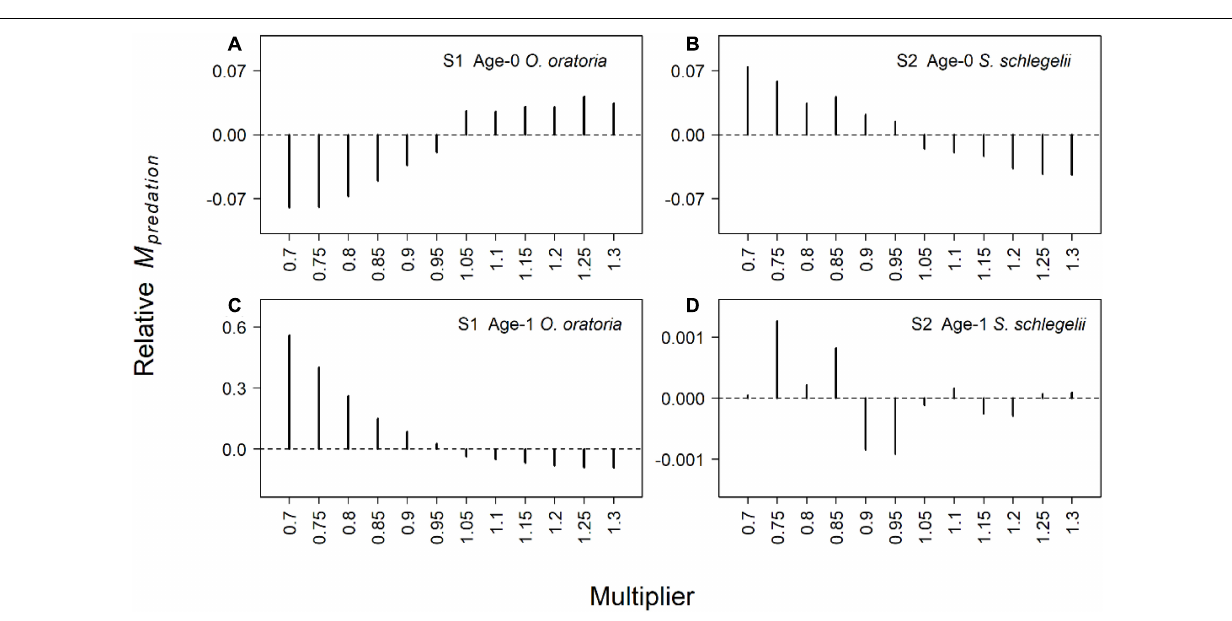
FIGURE 4 | Relative changes of predation mortality rate for two age groups of target species under different fishing scenarios. The relative changes were the difference between scenarios S1–2 and reference state. Scenarios S1 and S2 considered O. oratoria and S. schlegelii as target species, respectively. The fishing mortality multipliers of each non-target species were set from 0.7 (Fx0.7) to 1.3 (Fx1.3) with a step equal to 0.05. (A) Relative predation mortality of age-0 O. oratoria in S1, (B) relative predation mortality of age-0 S. schlegelii in S2, (C) relative predation mortality of age-1 O. oratoria in S1, and (D) relative predation mortality of age-1 S. schlegelii in